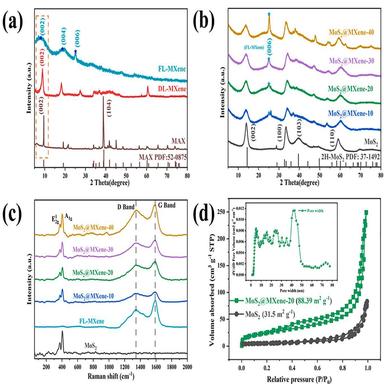
(a) XRD patterns before and after MAX etching, (b) XRD patterns of the MoS2@MXene composites, (c) Raman spectra of the MoS2@MXene composites, (d) N2 adsorption/desorption isotherms of MoS2 and MoS2@MXene-20 and pore size distribution curve of MoS2@MXene-20.